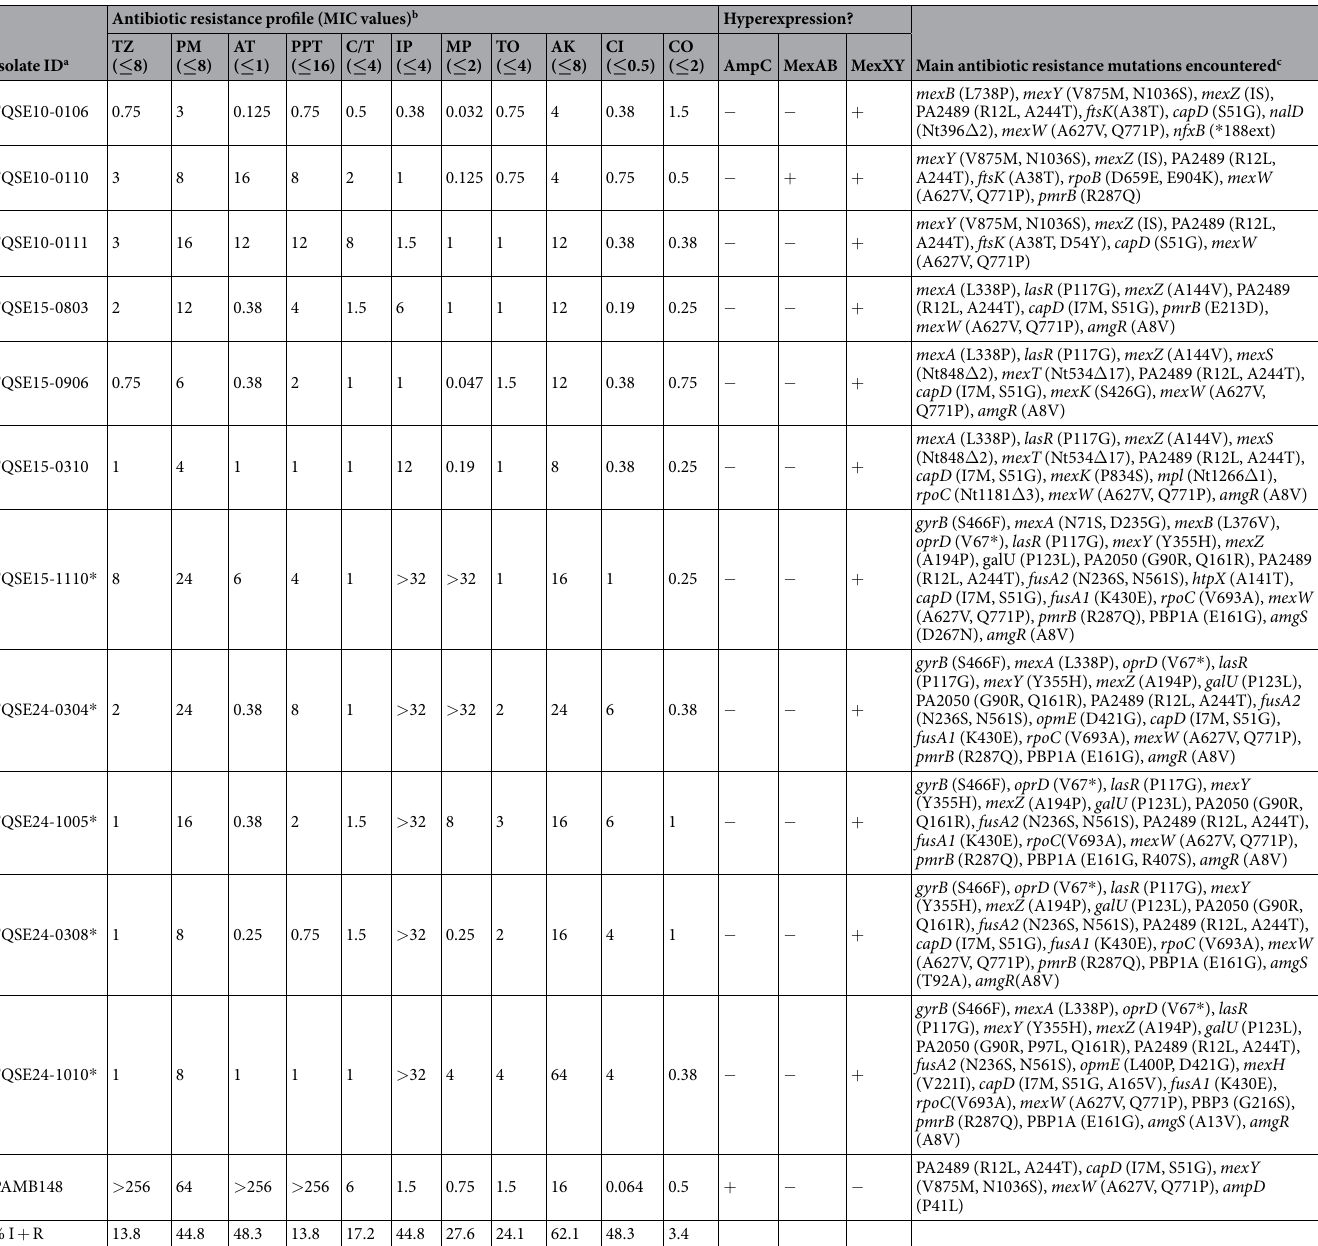
Table 2. Antibiotic susceptibility profile and main antibiotic resistance related mutations detected among CC274 isolates. a Isolates are labelled according to the following format: Patient identification - MMYY isolation code in the case of sequential isolates. Mutators isolates are identified with and asterisk. b Minimal Inhibitory Concentration (MIC) values were determined by grading MIC testing for the following antimicrobial agents: ceftazidime (TZ); cefepime (PM); aztreonam (AT); piperacillin-tazobactam (PPT); cefotolozane-tazobactam (C/T); imipenem (IP); meropenem (MP); tobramycin (TO); amikacin (AK); ciprofloxacin (CI) and colistin (CO). Clinical breakpoints established by EUCAST v7.0 for each antibiotic are shown in brackets. c The main antibiotic resistance related mutations documented for each isolate are shown. For this purpose, the full list of mutations in the 164 genes studied (available in Supplementary Data Set S1) was refined to include only those more likely to be involved in the resistance phenotypes, by including: (i) mutations with known effect on resistance according to published evidence (ii) mutations for which our experimental evidence crosslinks resistance phenotypes and genotypes ( e . g . mutations in genes involved in AmpC, efflux or OprD regulation and β -lactam resistance phenotypes are crosslinked by integrating the analysis of the expression of ampC , efflux pumps genes and oprD and/or (ii) mutations in genes found to be under high evolutionary pressure (those with at least 3 different mutational events